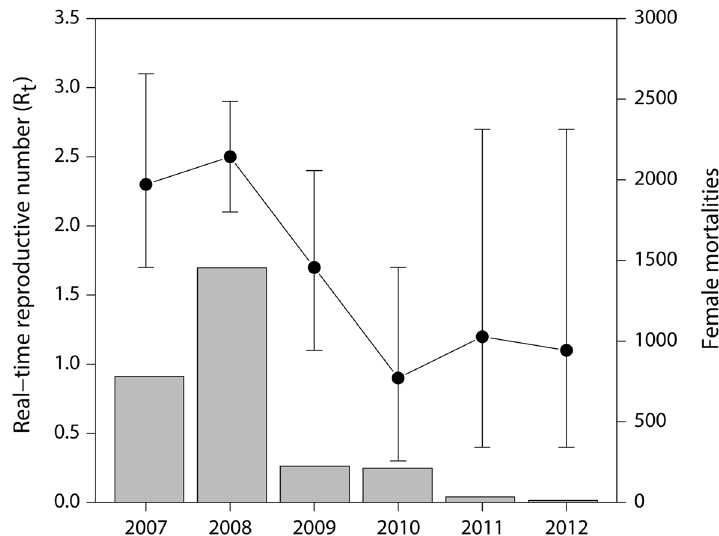
Figure 1. Real-time reproductive number (R t ) and observed mortalities of the avian cholera epidemic at the Northern common eider breeding colony located at Mitivik Island, Nunavut, from 2007 to 2012. Annual R t (± 95% c.i.) (black dots) calculated by Iverson et al . 26 and the annual number of female mortalities observed (grey